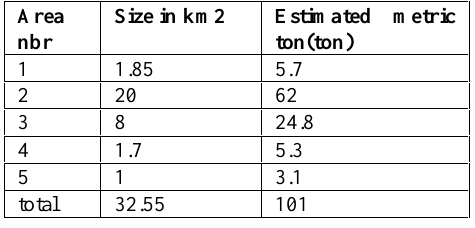
Table 2: Area size with estimated metric ton